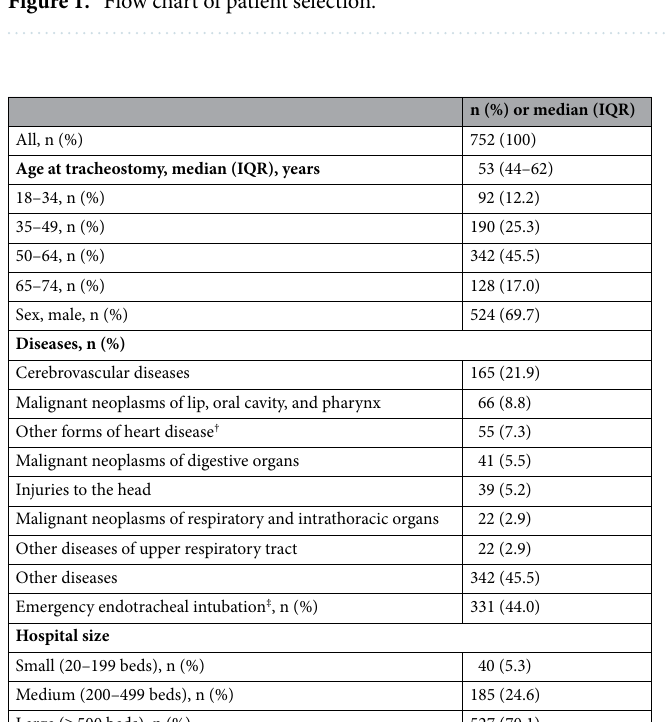
Figure 1. Flow chart of patient selection.